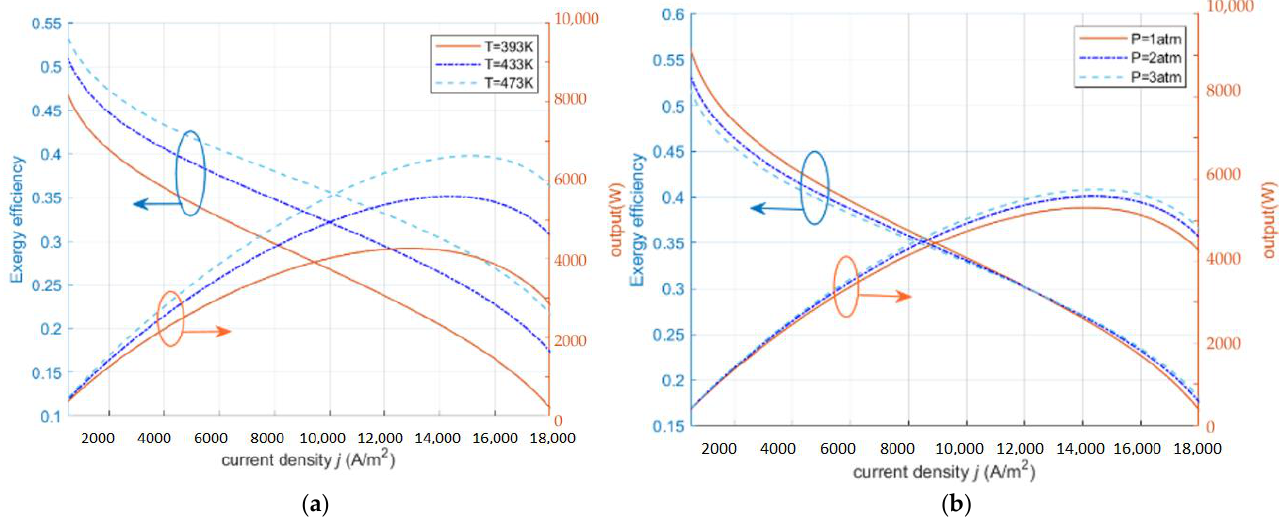
Figure 2. The effect of operating parameters on exergy efficiency and power density ( 𝑅𝐻 = 0.038% , 𝑡 𝑚𝑒𝑚 = 0.002 cm,𝐷𝐿 = 10 ). ( a ) different 𝑇 ; ( b ) different 𝑃